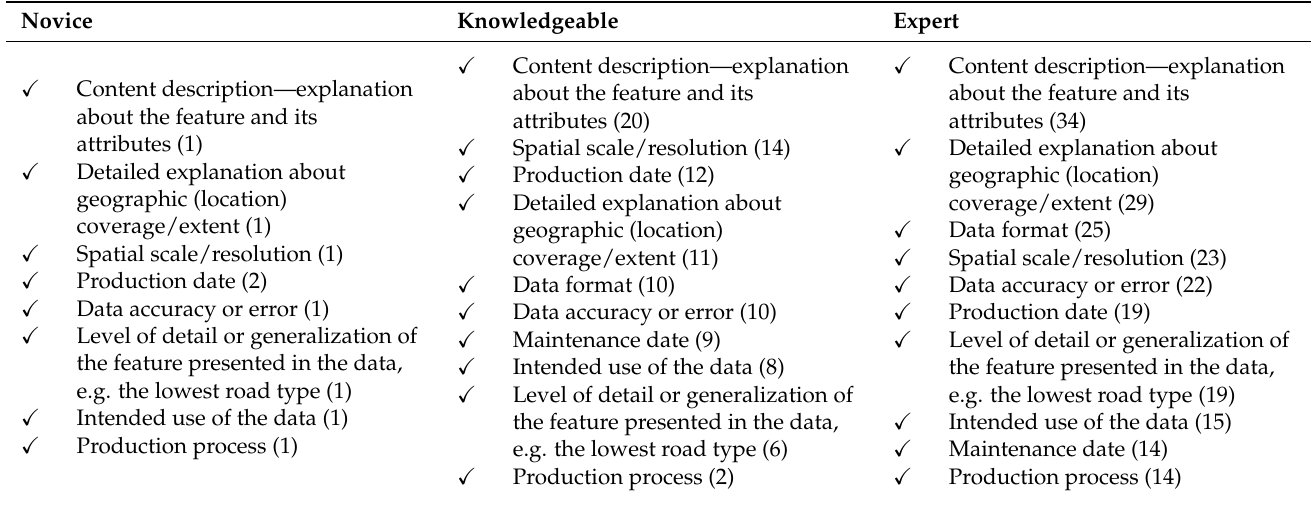
Table 11. Participants’ responses concerning information content for the abstracts. Novice Knowledgeable